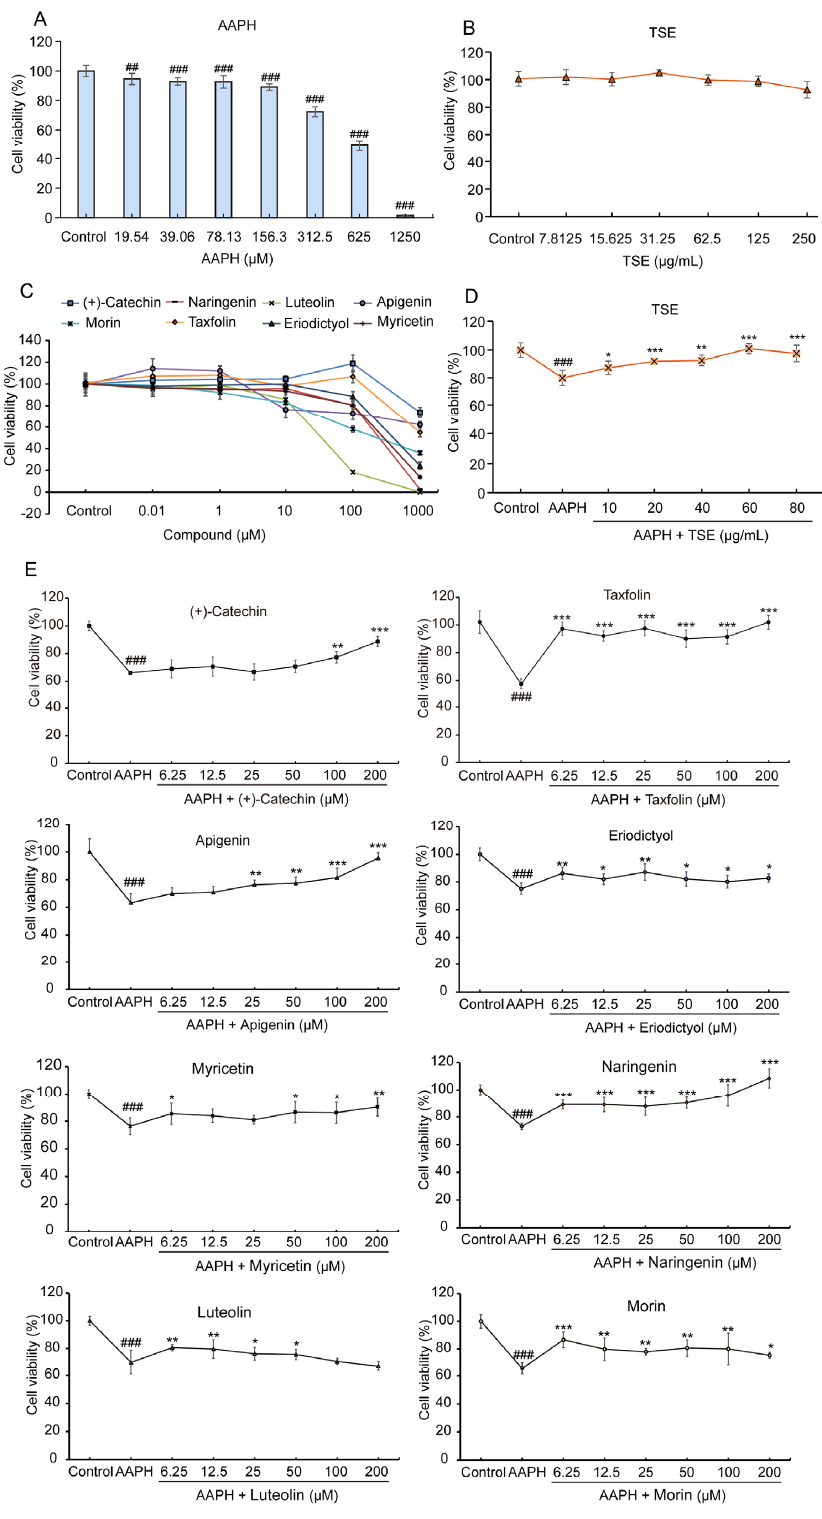
Figure 3. Effects of TSE and its eight flavonoids on AAPH-treated ATDC5 cell. ( A – C ) The cytotoxicity of AAPH, TSE and eight flavonoids in ATDC5 cells. n = 6. ( D , E ) Protective effect of TSE and its eight flavonoids against AAPH (400 μ M)-induced cell death in ATDC5 cells. n = 4–6. Data were expressed as mean ± SD and the statistical differences were analyzed by one-way ANOVA followed by LSD multiple comparisons test (IBM SPSS Statistics 25.0, Armonk, NY, USA). ## p < 0.01, ### p < 0.001 vs. the control group. * p < 0.05, ** p < 0.01, *** p < 0.001 vs. AAPH